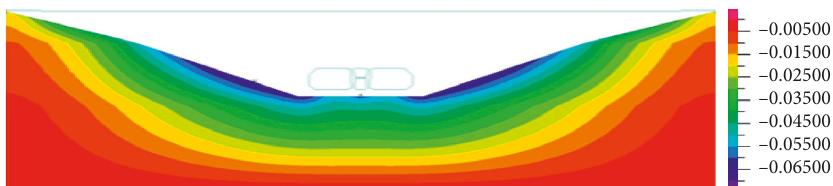
Figure 16: Displacement cloud map after backfill (unit: m).